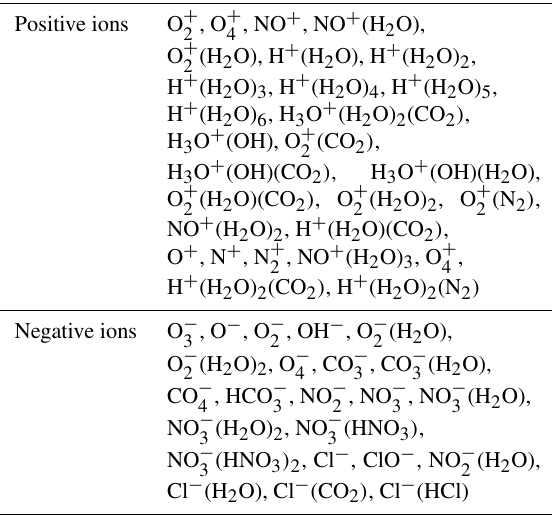
Table 2. Positive and negative ions included in WACCM-SIC. Positive ions